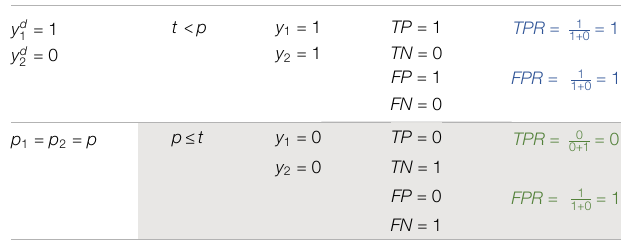
TABLE 5 | Example 4.